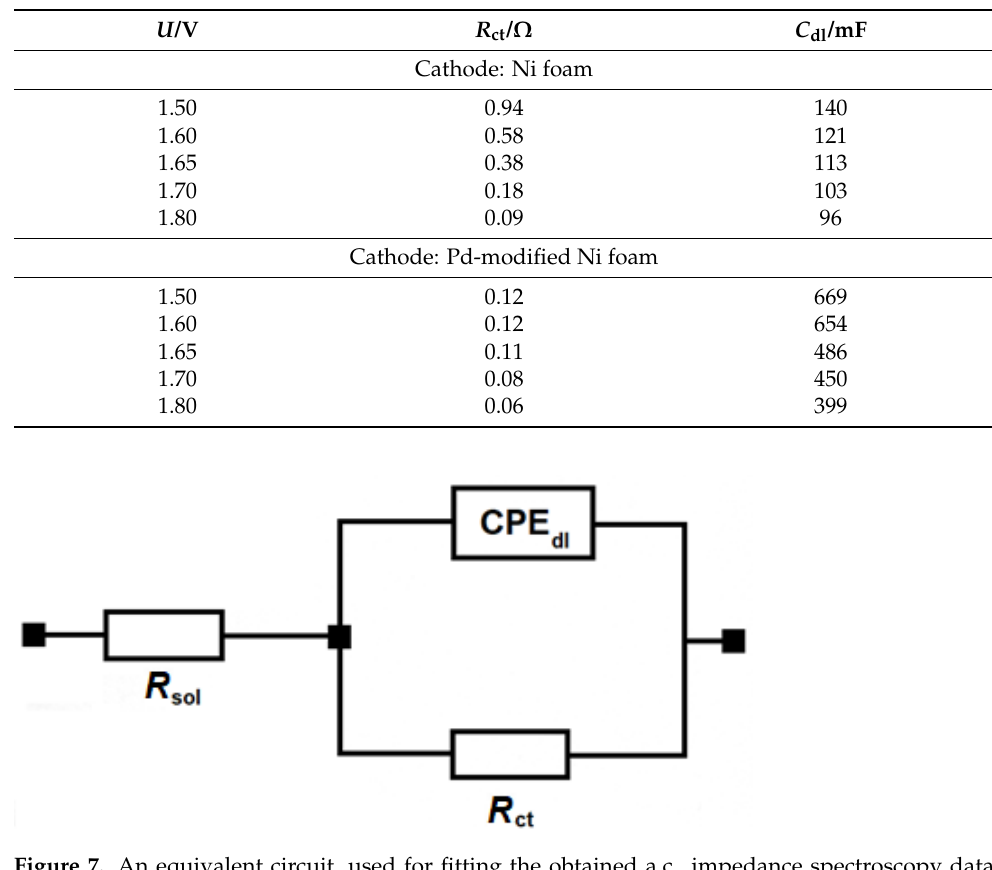
Figure 7. An equivalent circuit, used for fitting the obtained a.c. impedance spectroscopy data in this work, where: R sol is solution resistance, C dl is double-layer capacitance and R ct is a total charge-transfer resistance parameter. The circuit includes a constant phase element (CPE) to account for distributed capacitance.